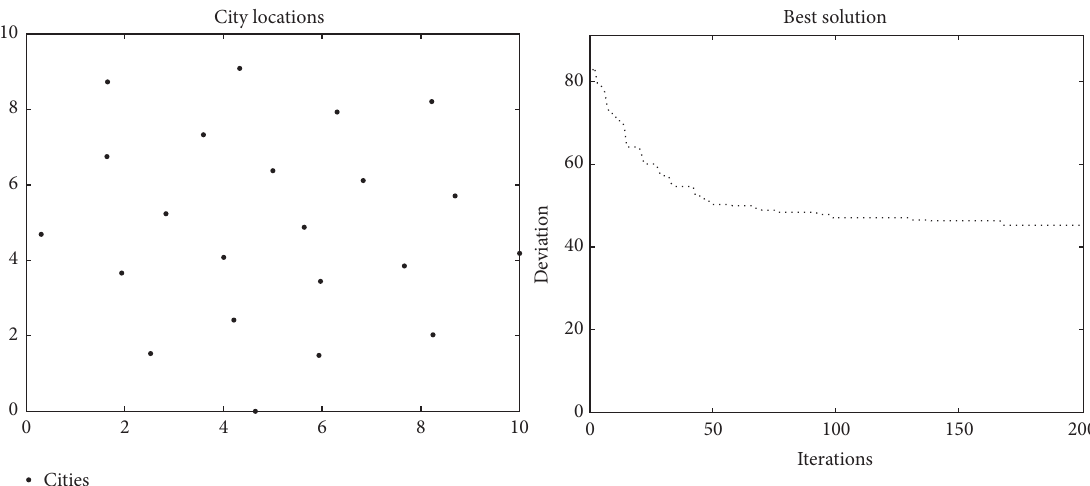
Figure 9: An example of best solution in stationarity. A sample of 22 cities generates a best route. As seen in the figure, there is a difference in optimality and time with nonstationarity.